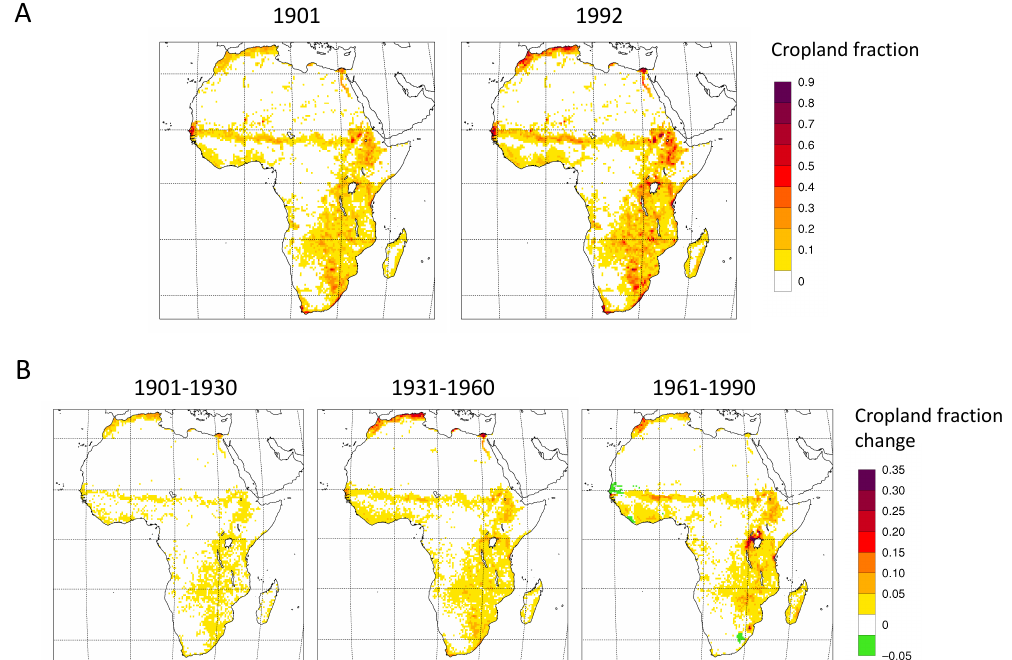
Fig. A2. (A.) Cropland fractions for the years 1901 and 1992. (B) Cropland fraction change for the time periods 1901–1930, 1931–1960 and 1961–1990. Green areas represent cropland abandonment. Values are derived from Ramankutty and Foley (1999).